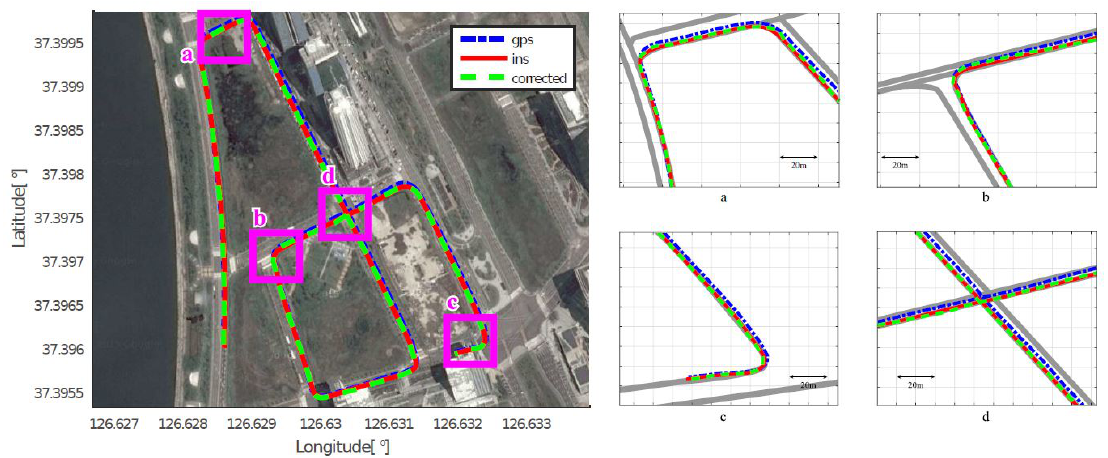
Figure 9. Experimental results for Course 2.